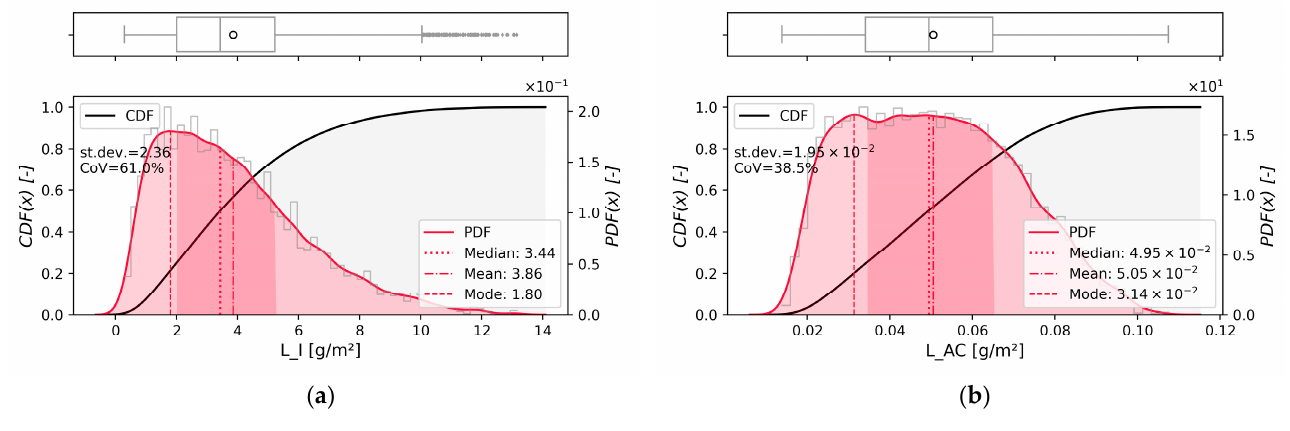
Figure 3. PDFs, CDFs, and box-whisker plots for L I ( a ) and L AC ( b ).